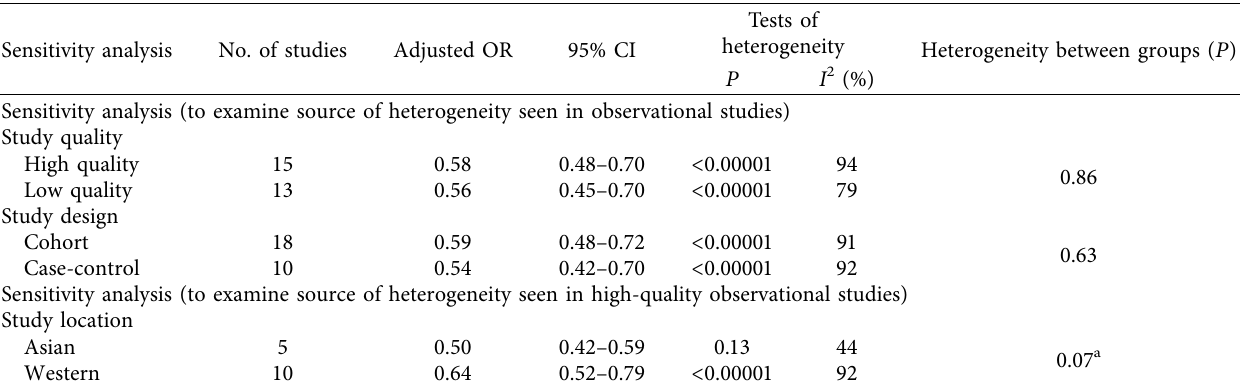
Table 4: Sensitivity analysis to examine sources of heterogeneity observed in summary